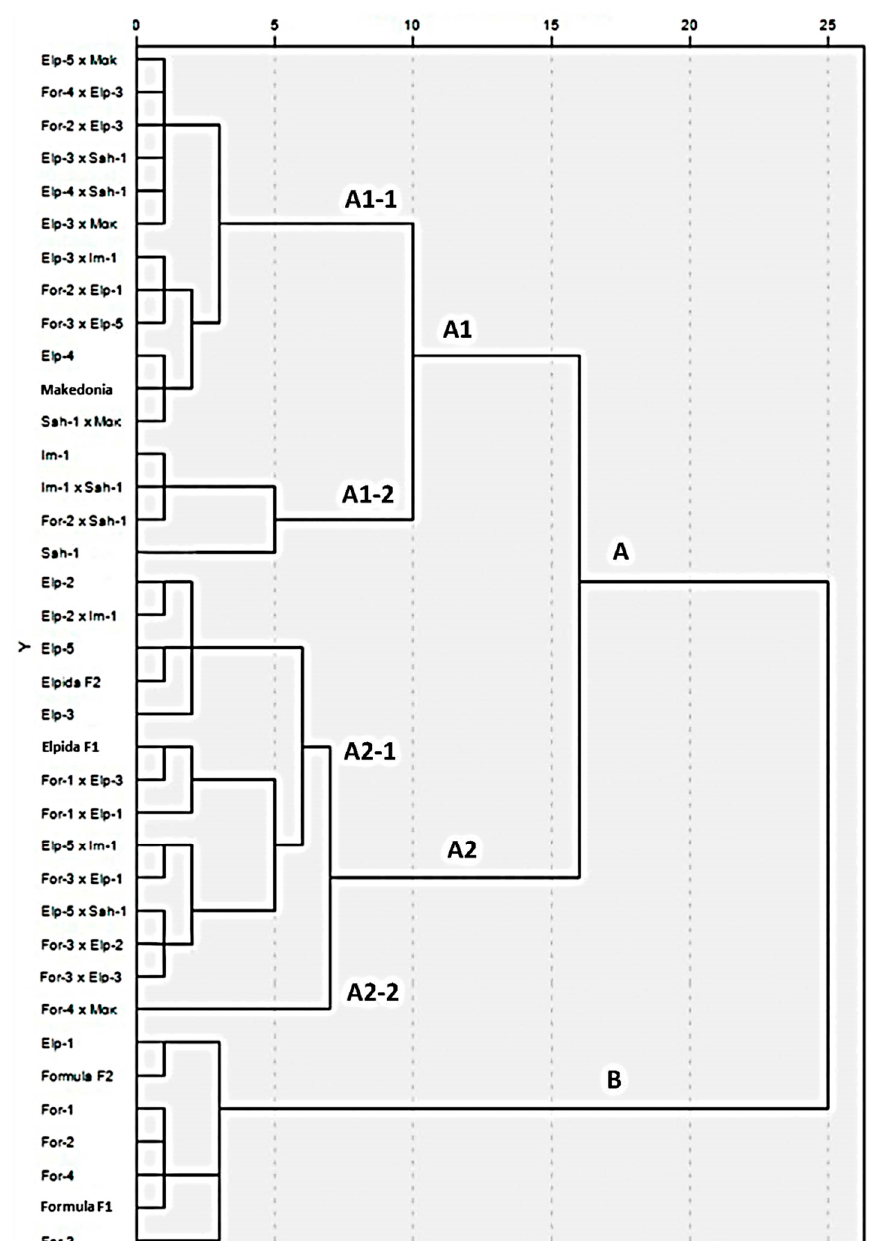
Figure 3. Dendrogram of hierarchical clustering of the original commercial hybrids, the recombinant inbred lines, and the reconstructed new hybrids according to Ward linkage and squared Euclidean distance method, based on 19 morphological characteristics.